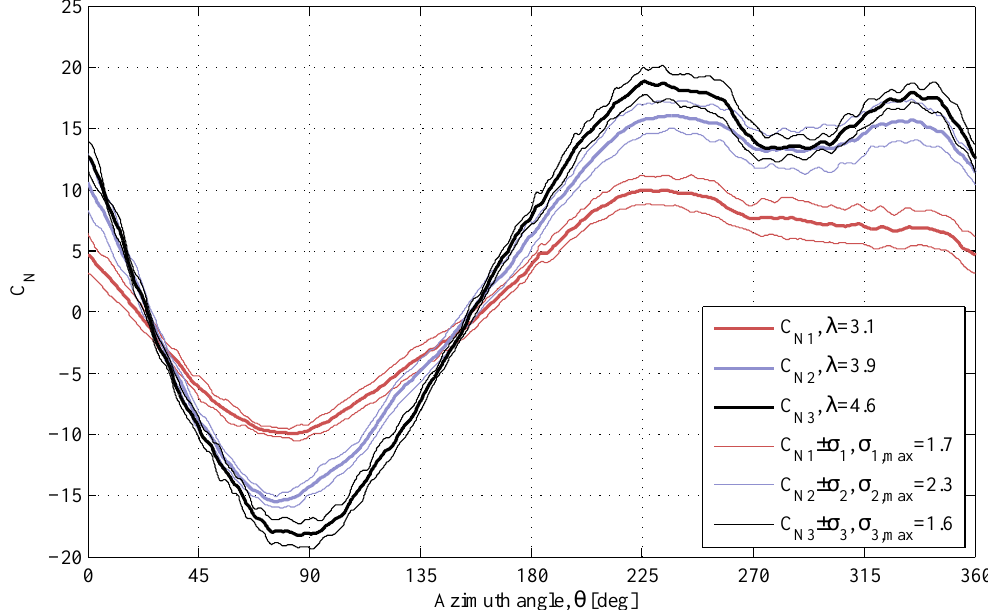
Figure 8. The average normal force coefficient at the turbine rotational speed of 65